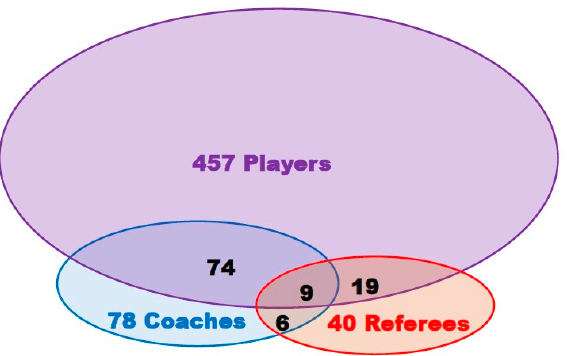
Figure 1. Number of respondents according to category of rugby practice and mutual interplay.